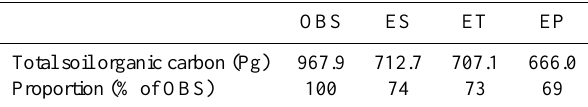
Table 2. Total SOC storage estimated from the ISRIC-WISE data set in the top 1m, using the Eq. (6) unit conversion, in comparison to those calculated with CLM at equilibrium (unmodified) and with each of the modifications described in the